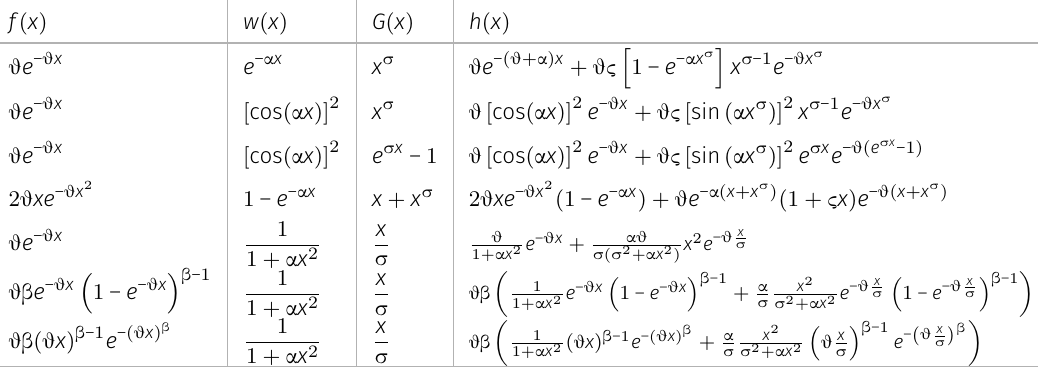
Table I. Some new pdfs h ( x ) h ( x ) h ( x ) , defined by (3), with various choices of f ( x ) f ( x ) f ( x ) , w ( x ) w ( x ) w ( x ) and G ( x ) G ( x ) G ( x ) (cid:63) . f ( x ) w ( x ) G ( x